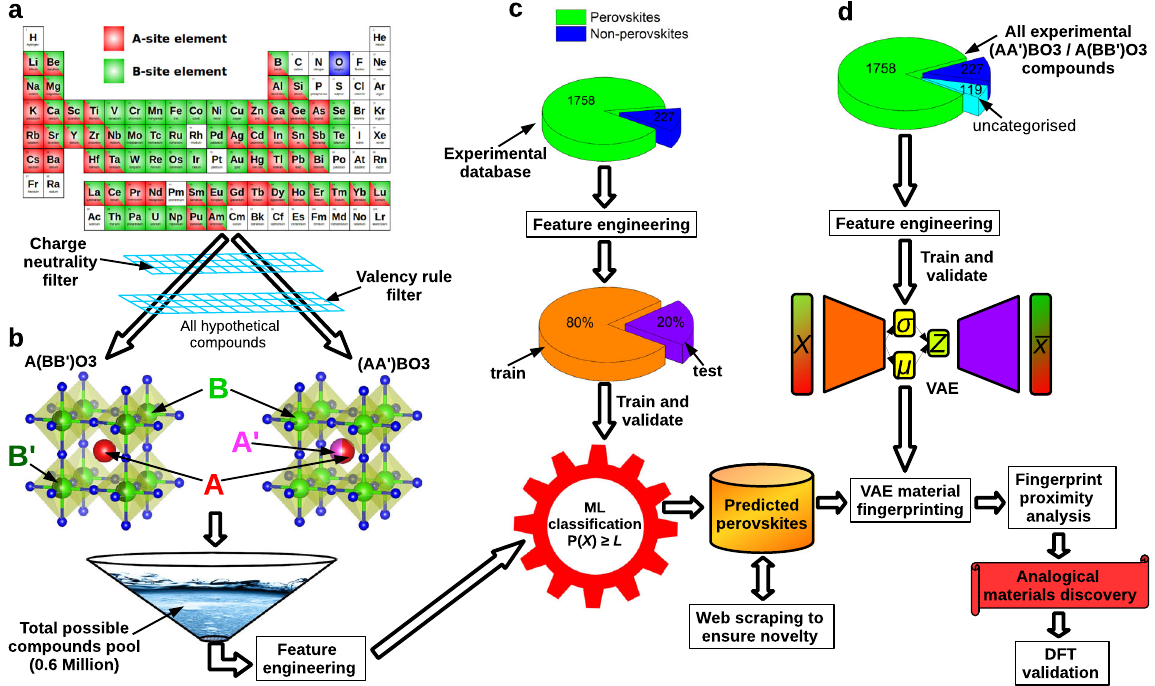
Fig. 1 Work fl ow demonstrating the analogical discovery of perovskites. a Elements that can fully or partially occupy octahedral and interstitial sites. b Average unit cells of ð A 1 (cid:2) x A 0 x Þ BO 3 and A ð B 1 (cid:2) x B 0 x Þ O 3 materials, usually realized by X-ray diffraction (XRD) analysis. During total possible chemical formulae generation, Pauling ’ s valency rule is imposed by restricting the mean oxidation state of the A-site ( n A ) to be less than or equal to that of B-site ( n B ); ( n A (cid:3) n B ). We further set the condition, mean ionic radius of A-site ( R A ) should be greater than or equal to that of B-site (